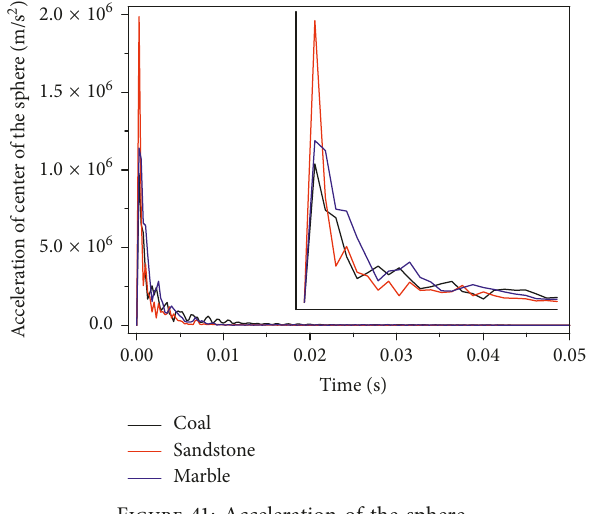
Figure 41: Acceleration of the